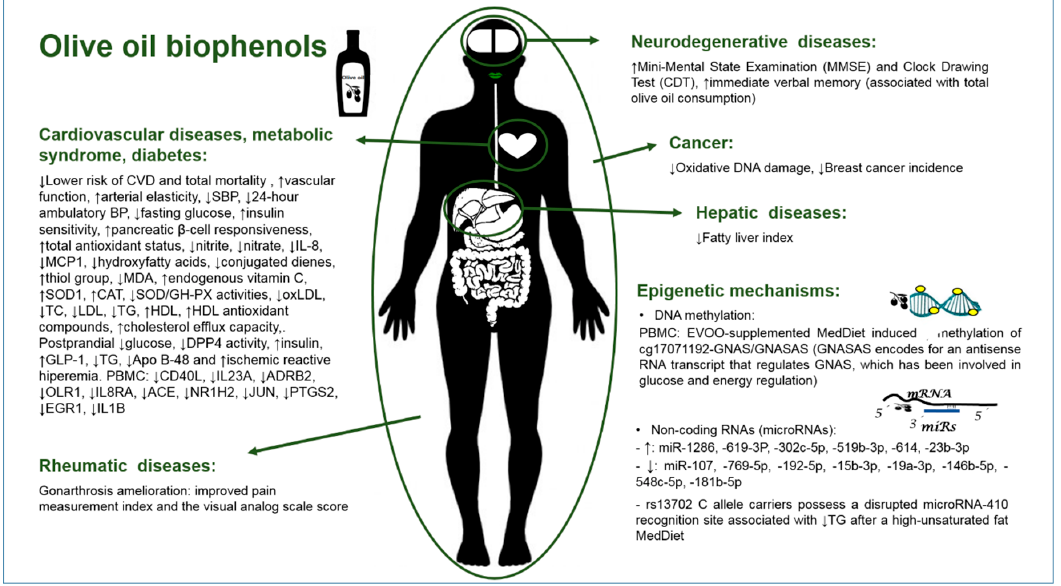
Figure 1. Clinical trials-derived evidence regarding biophenol-rich olive oils’ benefits and mechanisms.